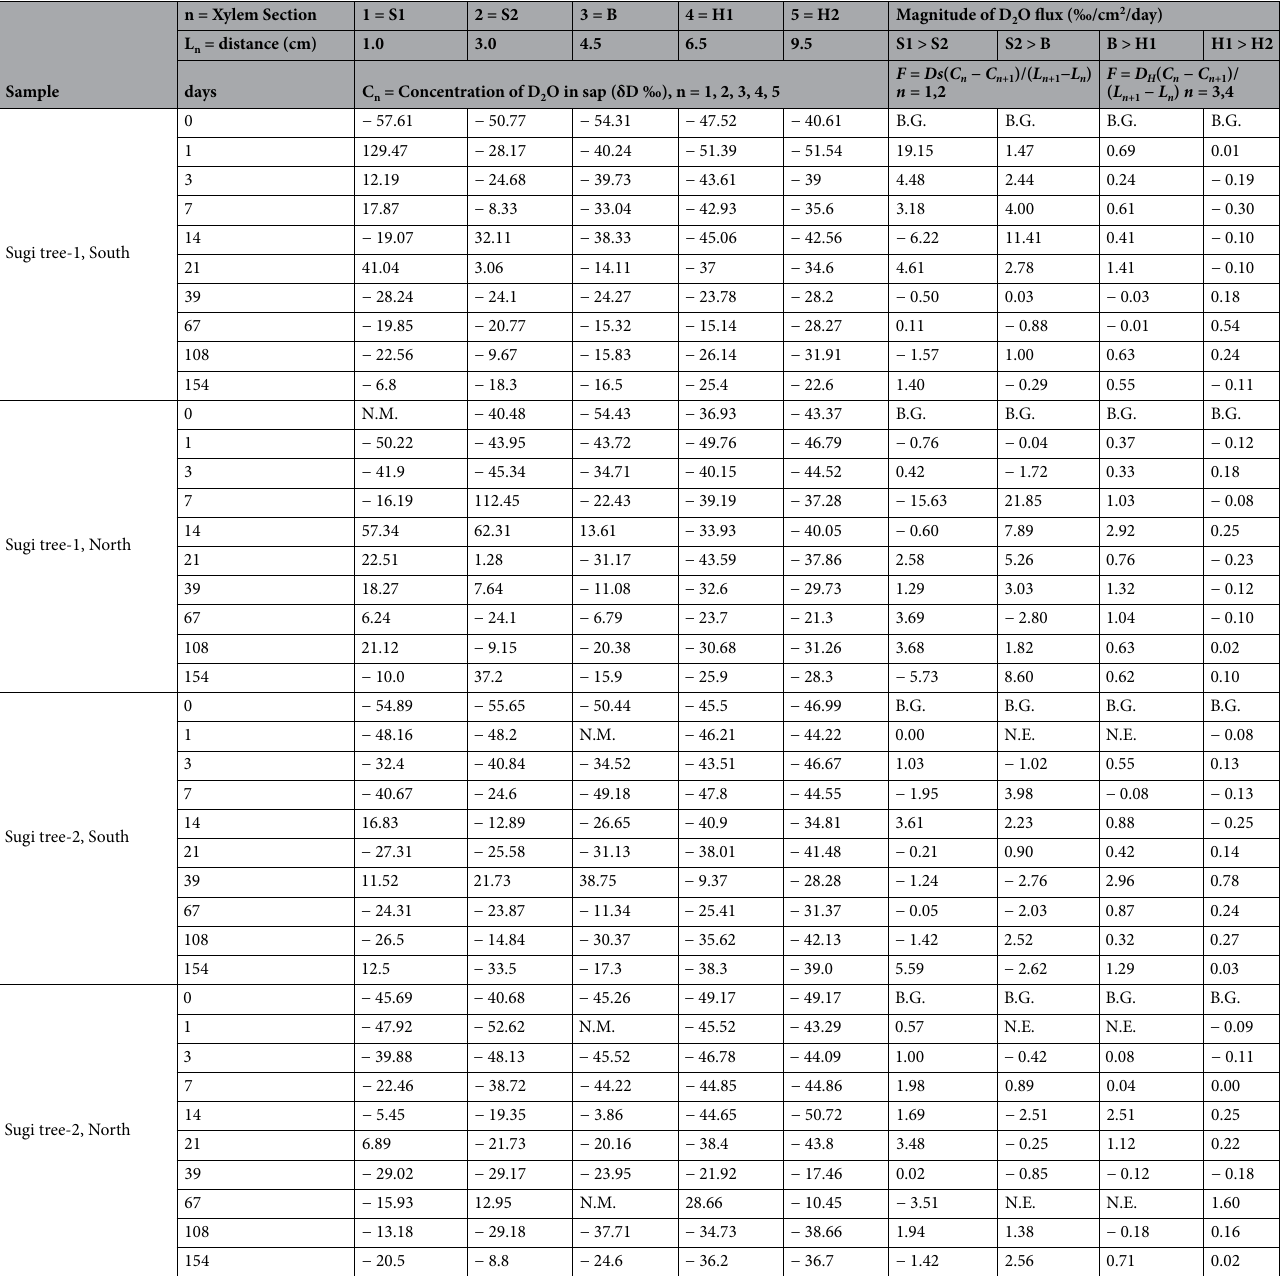
Table 2. Distribution of the D 2 O tracer in the xylem stem of sugi trees and the magnitude of the D 2 O diffusion flux ( F = − D ·(d C /d x ) = D· ( C n − C n+1 )/ L ) 36 from one xylem section to the adjacent section 154 days after spreading of the D 2 O tracer solution. D: diffusion coefficient, Ds = 0.243 cm 2 day −1 is sapwood, D H = 0.123 cm 2 day −1 is heartwood (see Table 1); C a and C b are the measured δD concentrations in neighboring xylem sections a and b; L is distance between two neighboring xylem sections n and n + 1; B.G. is background, N.M. is not measurement, N.E. is not